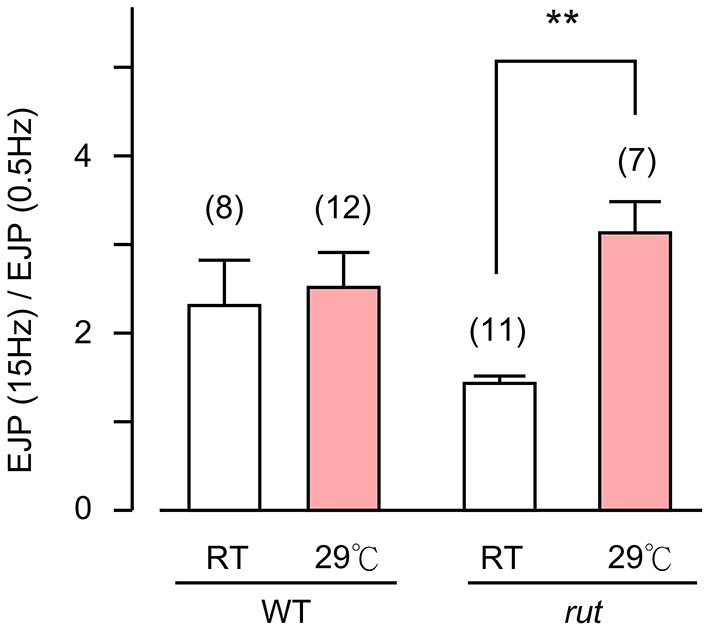
Altered activity-dependent facilitation of EJPs in rut larvae. EJPs in rut larvae displayed enhanced facilitation when reared at HT. Ratios of EJP amplitudes evoked by 15-Hz–0.5 Hz provides an index for facilitation. Stimulus trains (10 s, 15 Hz) were applied and average EJP amplitudes were determined between 5–10 s. **p < 0.01, t-test with sequential Bonferroni adjustment for multiple comparisons of RT vs. HT. Number of muscle fibers indicated in parentheses. Error bars indicate SEM.